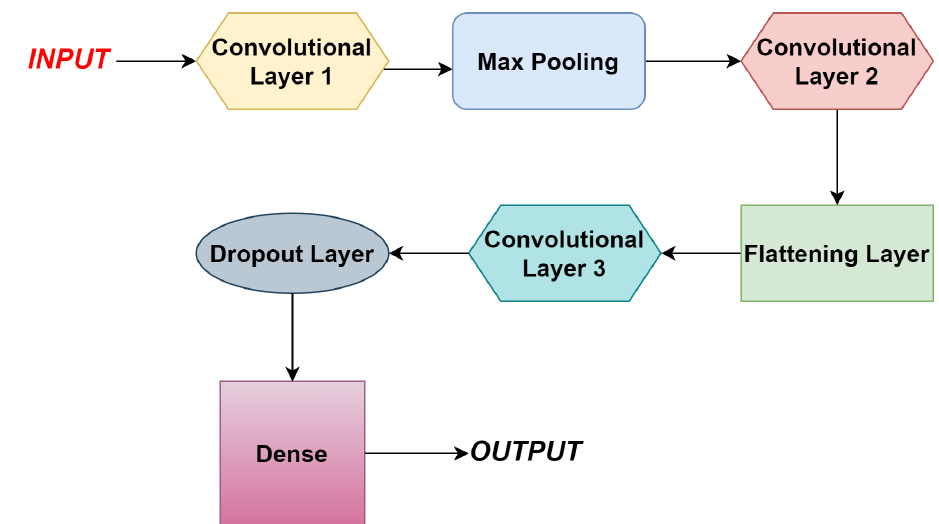
Figure 2. CNN architecture for classification of attacks in IoT Networks.